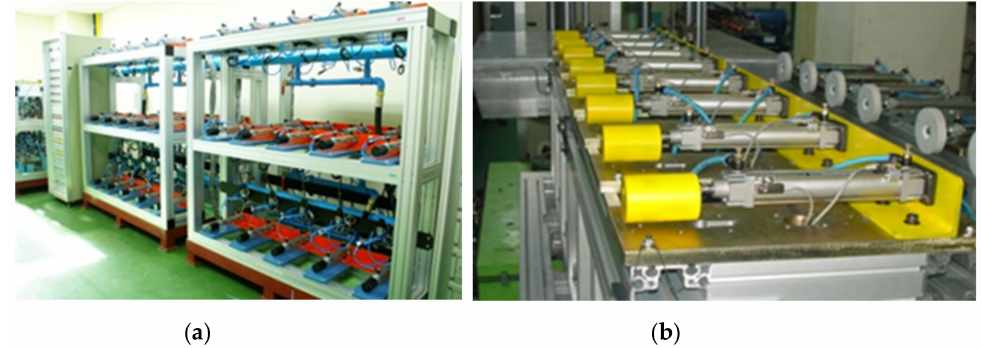
Figure 10. Equipment for the ALTs; ( a ) test facility, ( b ) accelerated testing for cylinders mounted on load